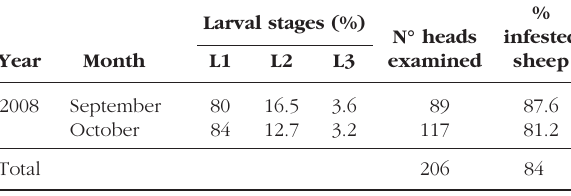
Table I. – Monthly prevalence rates of ovine Oestrosis and larval stages (L1, L2 and L3) found in sheep from Majorca (Balearic